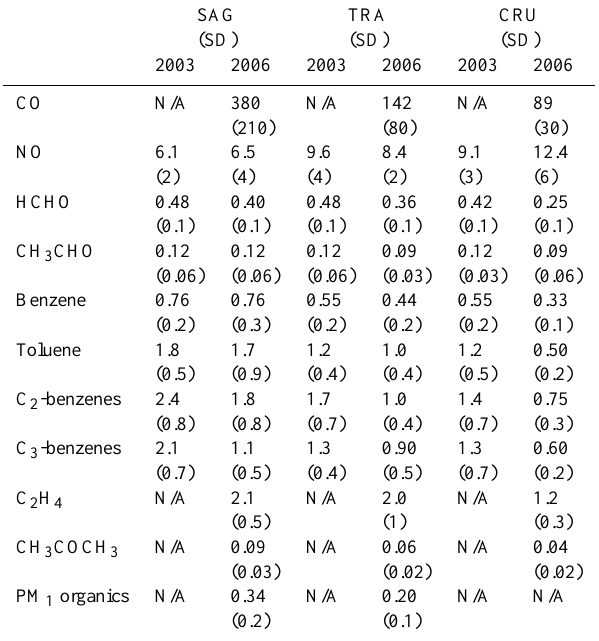
Table 2. Comparison of measured gasoline fleet-average fuel-based mobile emission factors in 2003 and 2006 in Mexico City for vari- ous driving modes a